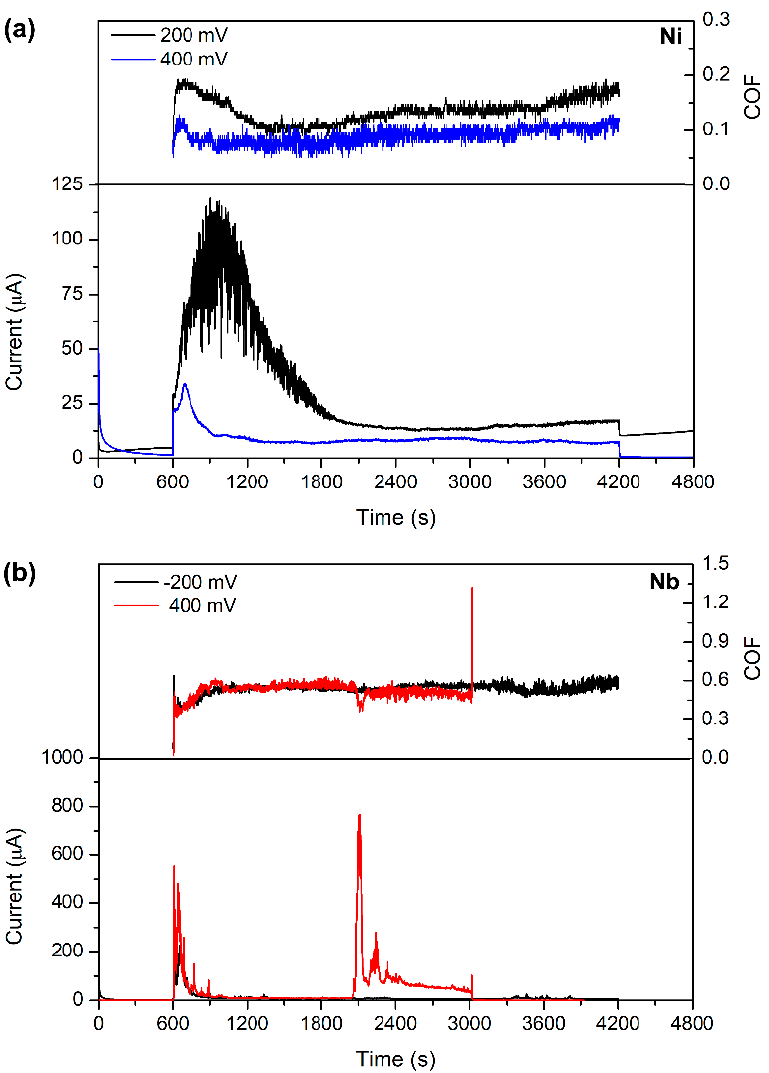
Figure 4. Evolutions of current and COF during the potentiostatic tribocorrosion tests: ( a ) Ni and ( b ) Nb.